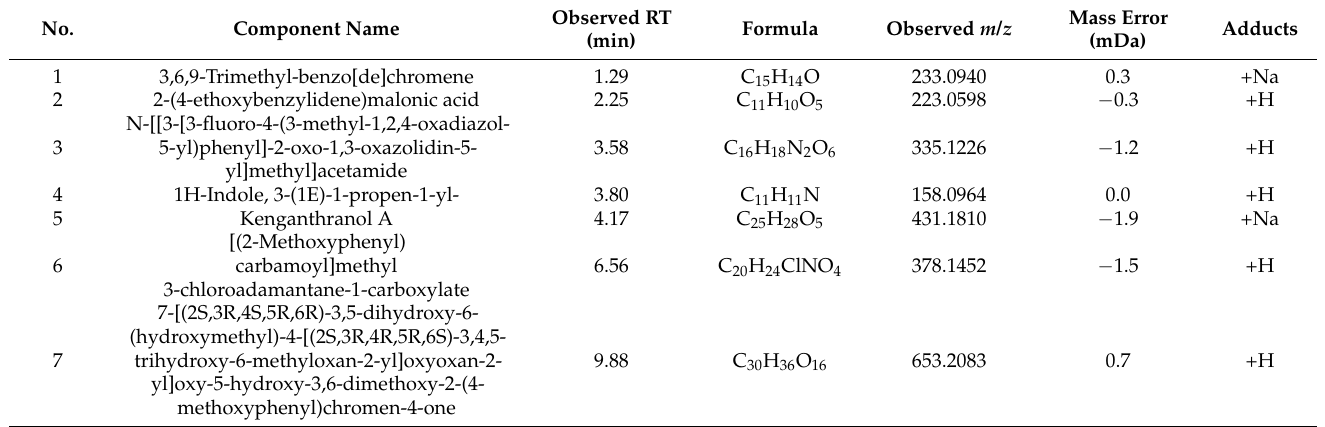
Table 4. List of components in THA-663S identified by